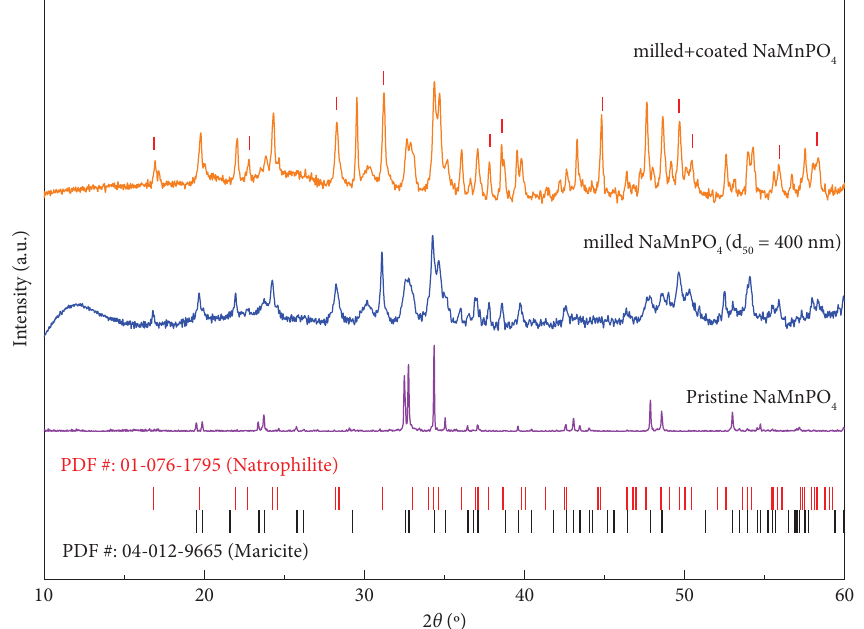
Figure 3: Te XRD patterns of pristine m-NaMnPO